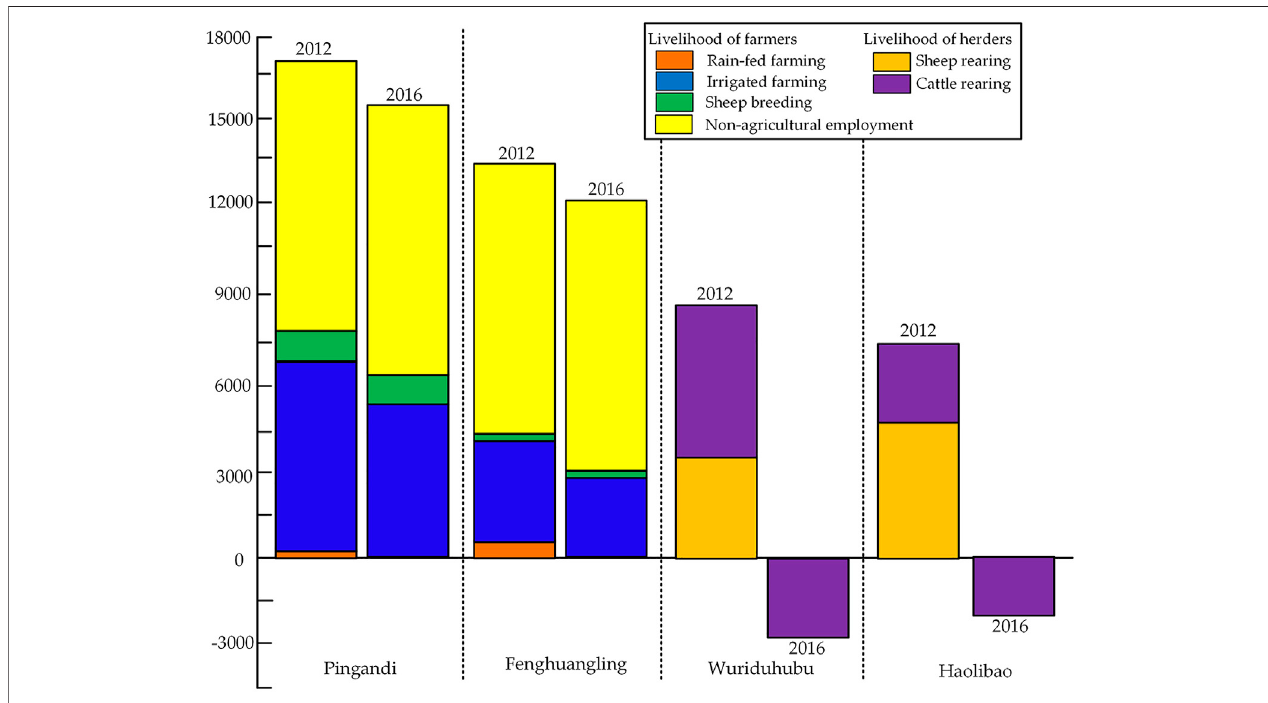
FIGURE 6 | The incomes of farmers and herders before and after the drought.